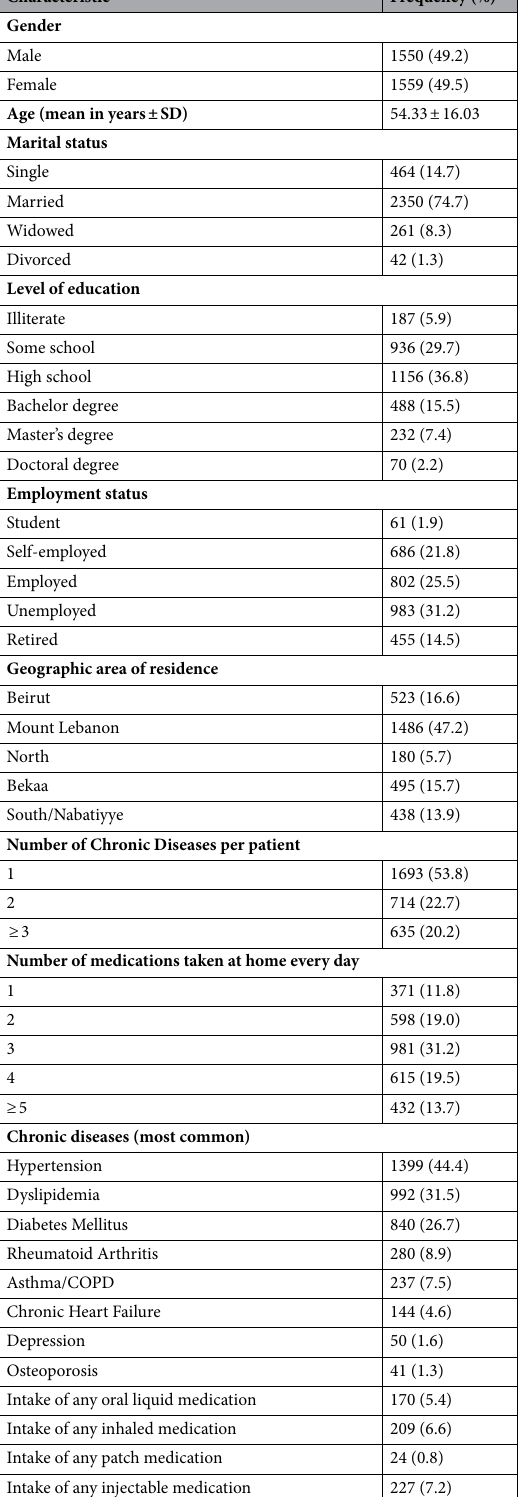
Table 1. Sociodemographic characteristics and medical condition. a Sometimes the cumulative percentages may not reach 100% due to missing values. When missing values are less than 10%, they were not reported